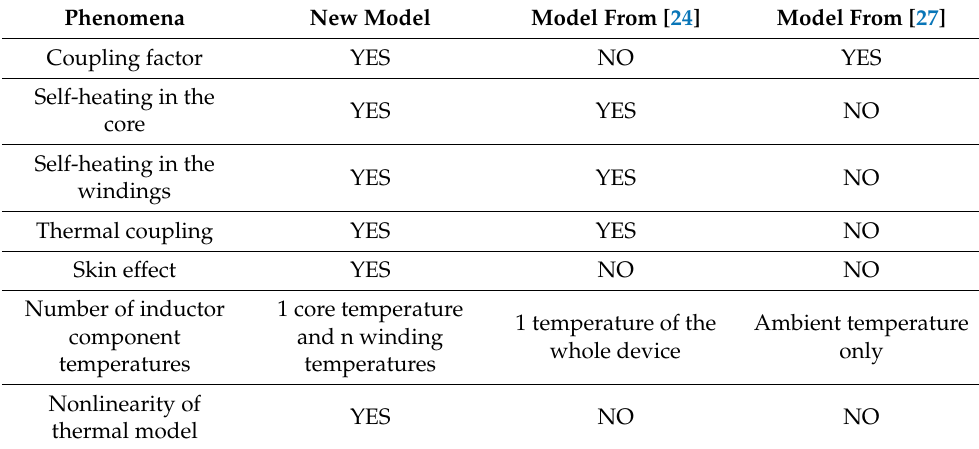
Table 4. The phenomena included in the models described in the current paper and in papers